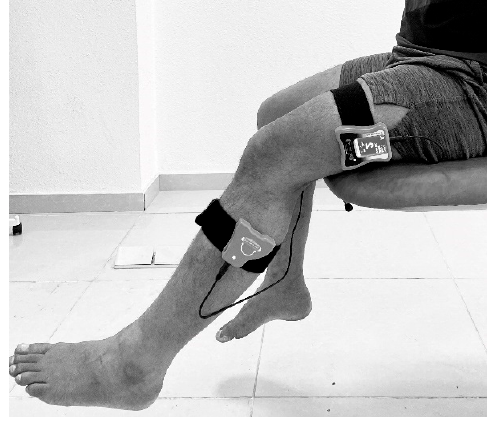
Figure 1. Testing knee joint position sense.